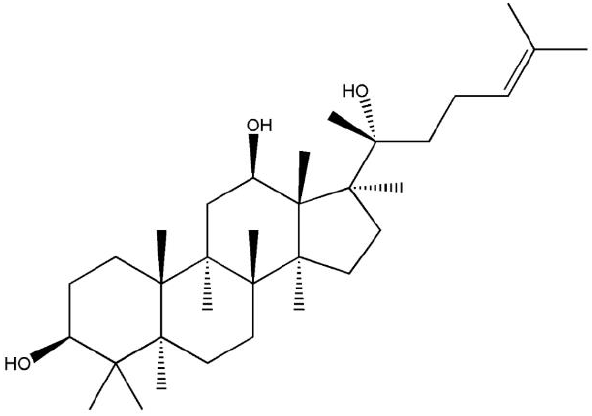
Figure 1. Structure of 20(S)-Protopanaxadiol.